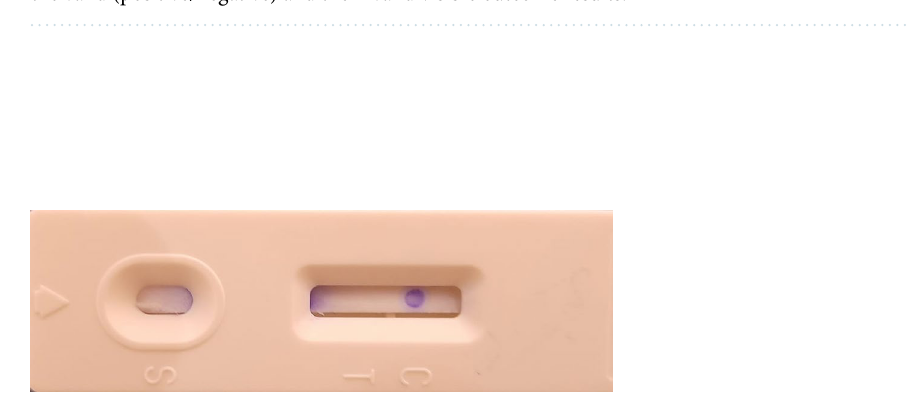
Figure 2. Demonstration of the negative reaction appearance in the newly developed